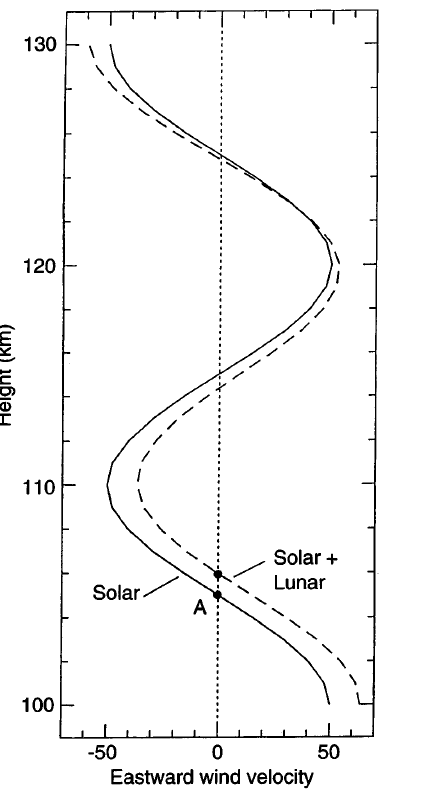
Fig. 4. Theory of lunar tide in Es. The solid line is a tidal wind with k = 20 km. The dashed line shows the e(cid:128)ect of addition of another z tide with k = 60 km. The point A indicates the height of formation z of sporadic E